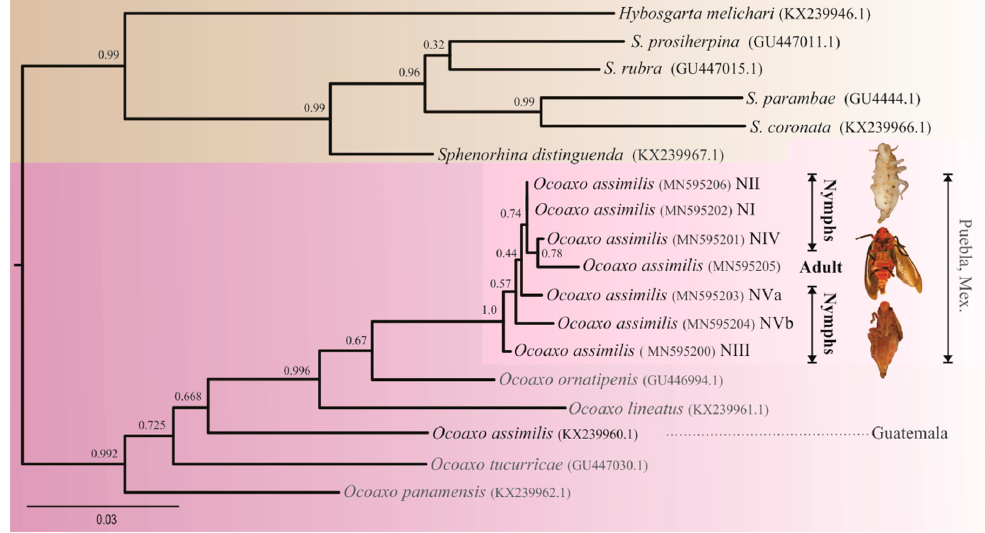
Figure 4. Phylogenetic tree resulting from ML analysis of 970 bp cytochrome oxidase I (COI) sequences, obtained from both nymphal and adult specimens of Ocoaxo assimilis and other Cercopids. The model with the best fit for nucleotide substitution was TIM2+I+G ( ⸺ LnL = 3937.7517; AIC = 7962.5, K = 42 G = 0.224). Support values at nodes were derived from 1000 pseudo replicates. Nymphal stages one to five (NI, NII, NIII, NIV, NVa, and NVb).